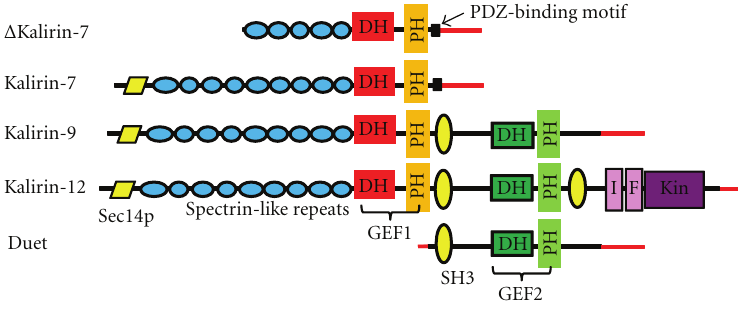
Figure 1: Major Kalirin isoforms. Alternative splicing generates di ff erent isoforms of Kalirin. DH: Dbl homology; PH: pleckstrin homology; GEF1: guanine nucleotide exchange factor 1; SH3: Src homology domain; GEF2: guanine nucleotide exchange factor 2; I: immunoglobulin- like; F: fibronectin III-like; Kin: kinase domain; red lines, unique 5 (cid:2) - and 3 (cid:2) -untranslated